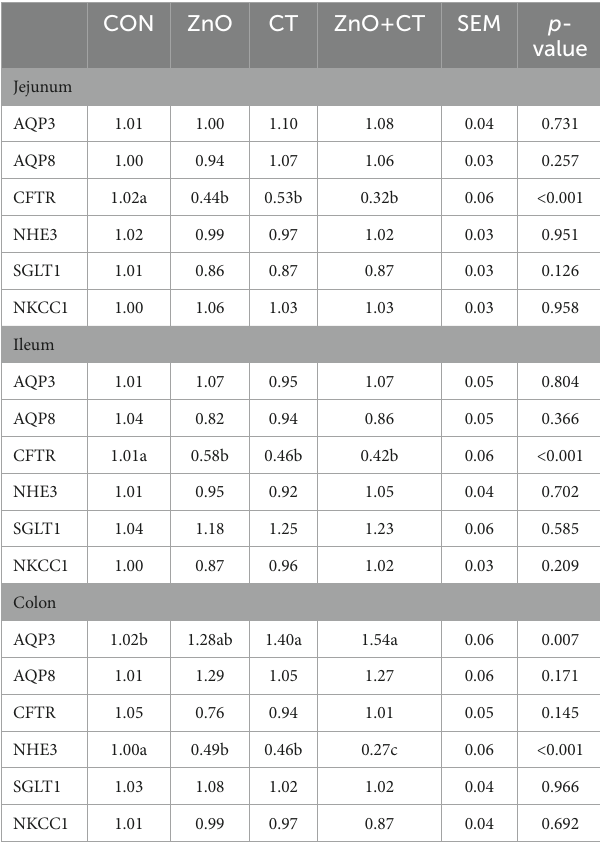
TABLE 5 Effects of ZnO and CT on diarrhea-related channel gene expression in weaned piglets under K88-challenged environment. CON ZnO CT ZnO +